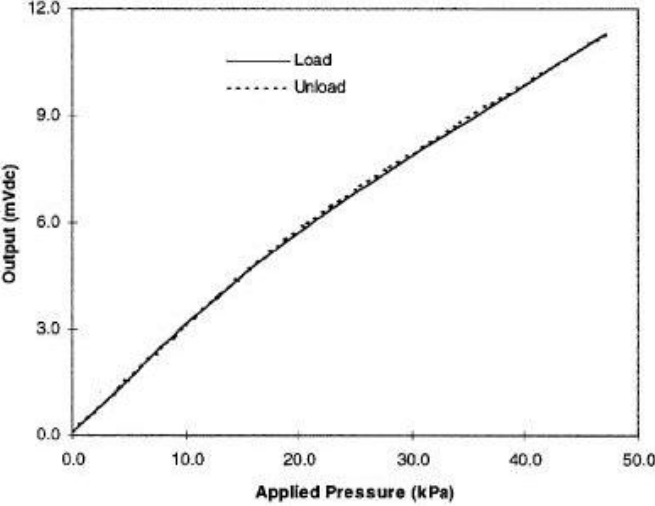
Figure 7. Negligible hysteresis of MEMS-based pressure sensor